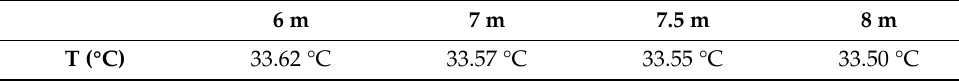
Figure 17. Measurement LiDAR map for a person at about 6 m. Table 8. Body temperature measurement result by